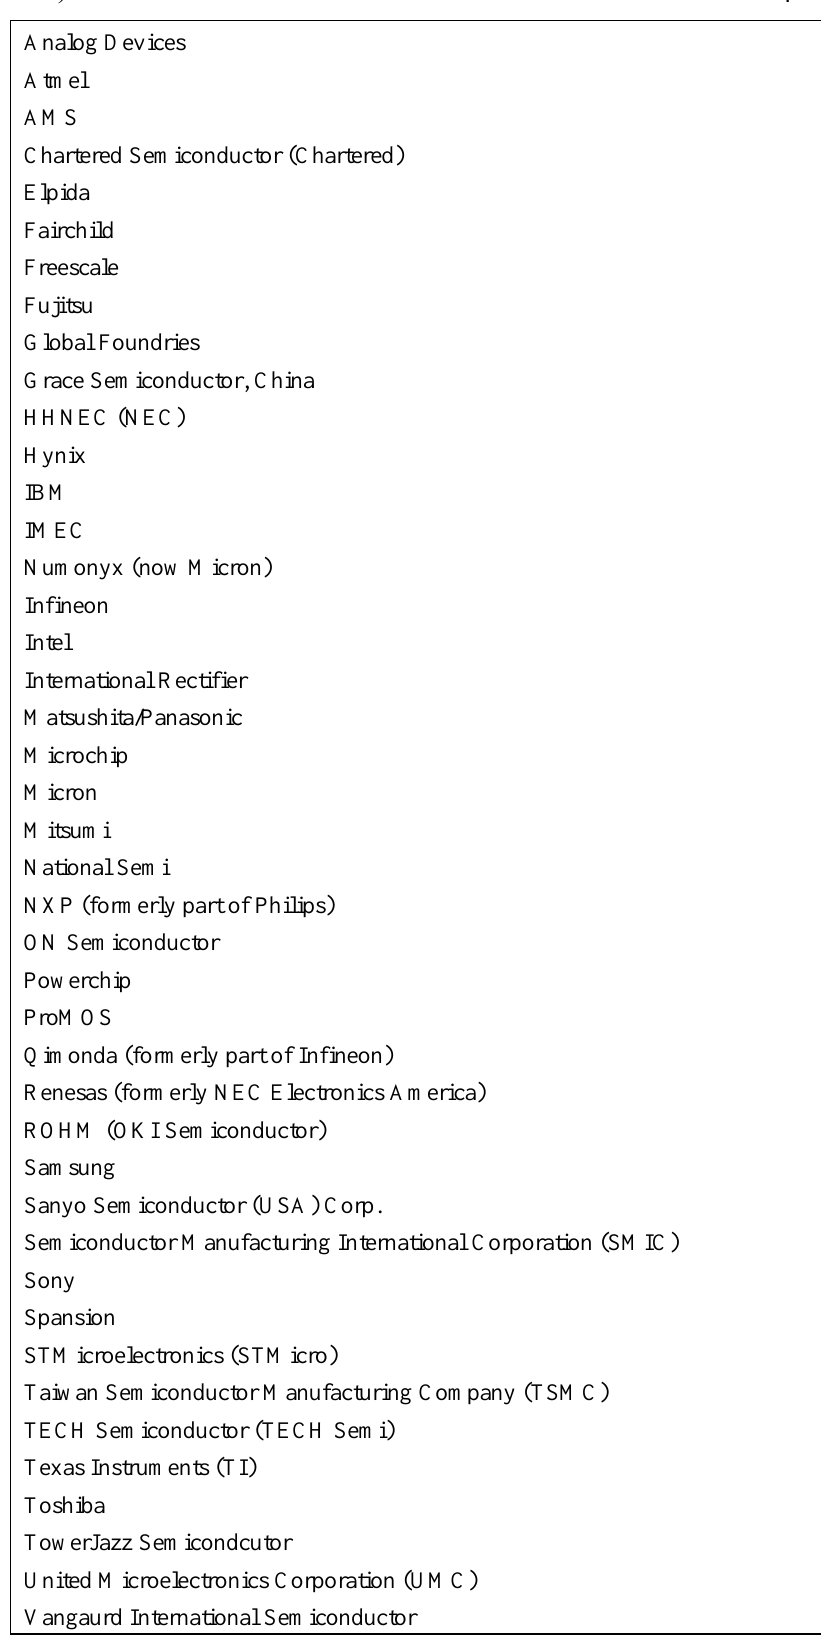
Table 1. Major worldwide foundries (for digital and analogue ICs). The list includes companies that manufacture primarily their own IC designs (known as ‘integrated device manufacturers’) and ‘dedicated foundries’ that manufacture for fabless